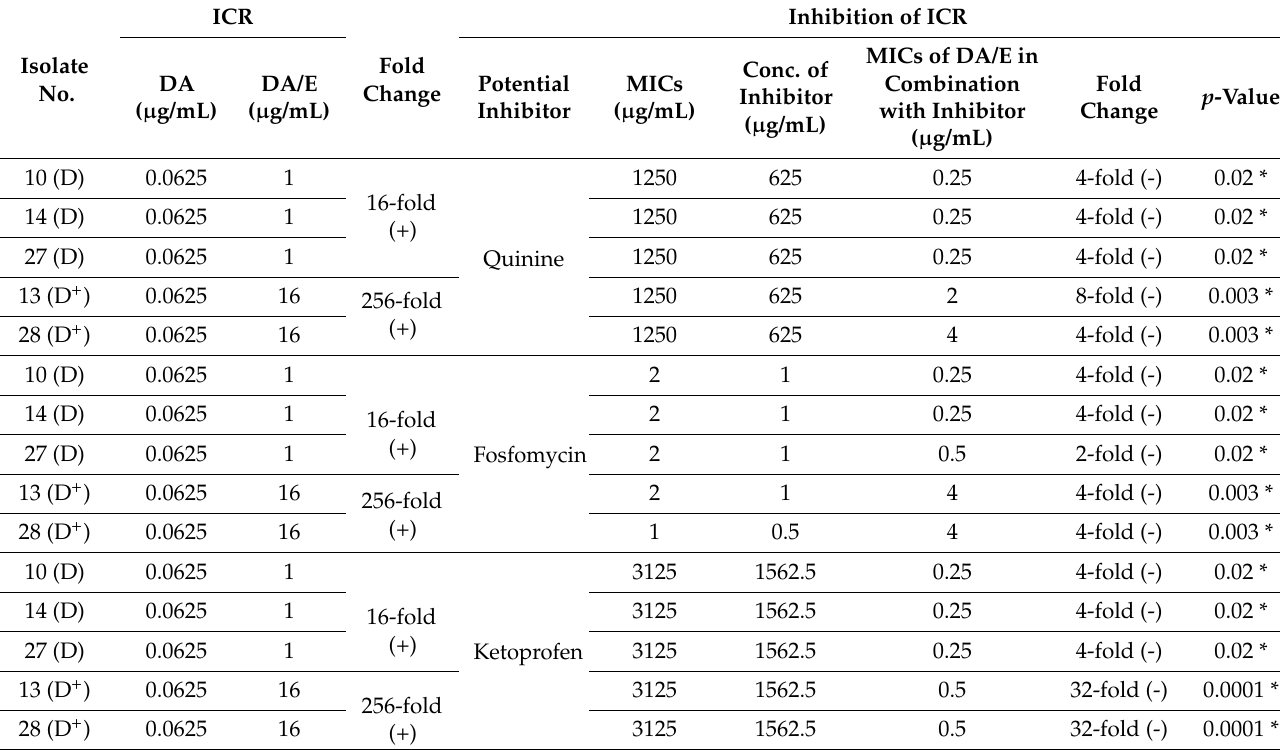
Table 3. Effect of potential inhibitors on inducible clindamycin resistance against S. aureus isolates no. 10, 14 and 27 (D phenotype) and isolates no. 13 and 28 (D +